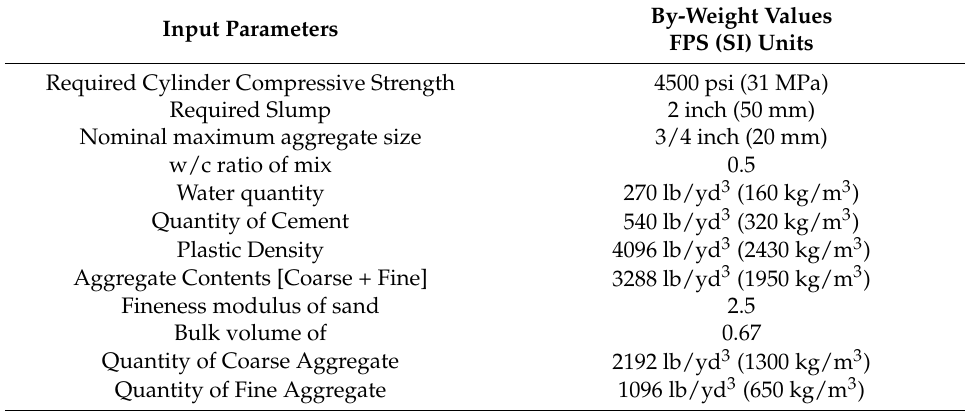
Table 4. Mix design quantities of standard constituents of control specimen .